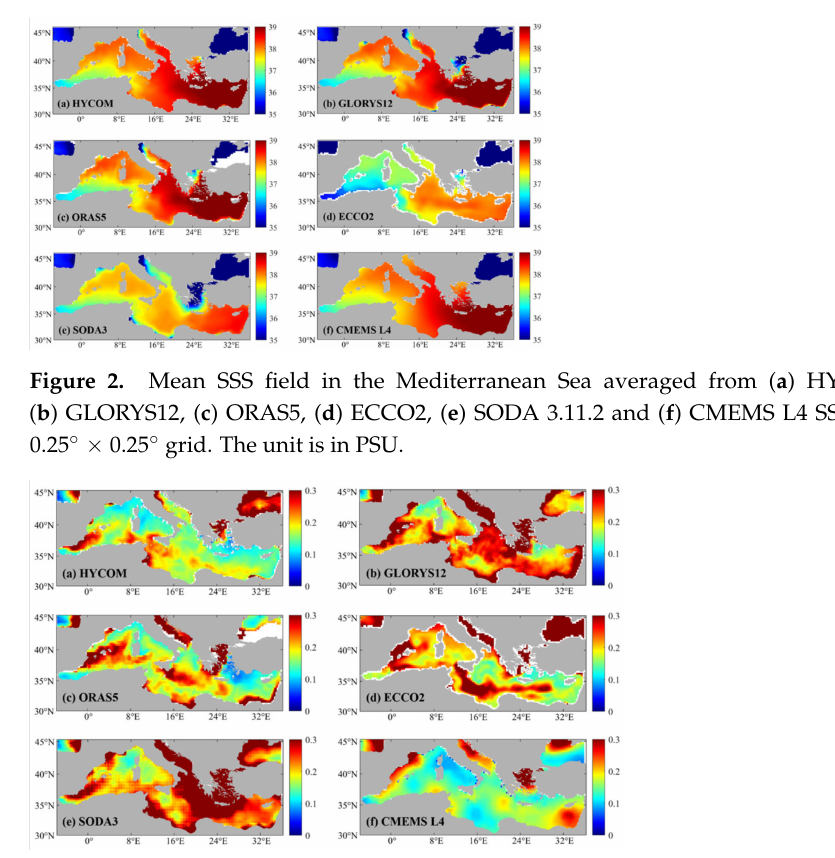
Figure 3. Same as Figure 1 but for the STD field. The unit is in PSU. Ten subregions in the Mediterranean Sea are divided to evaluate the SSS